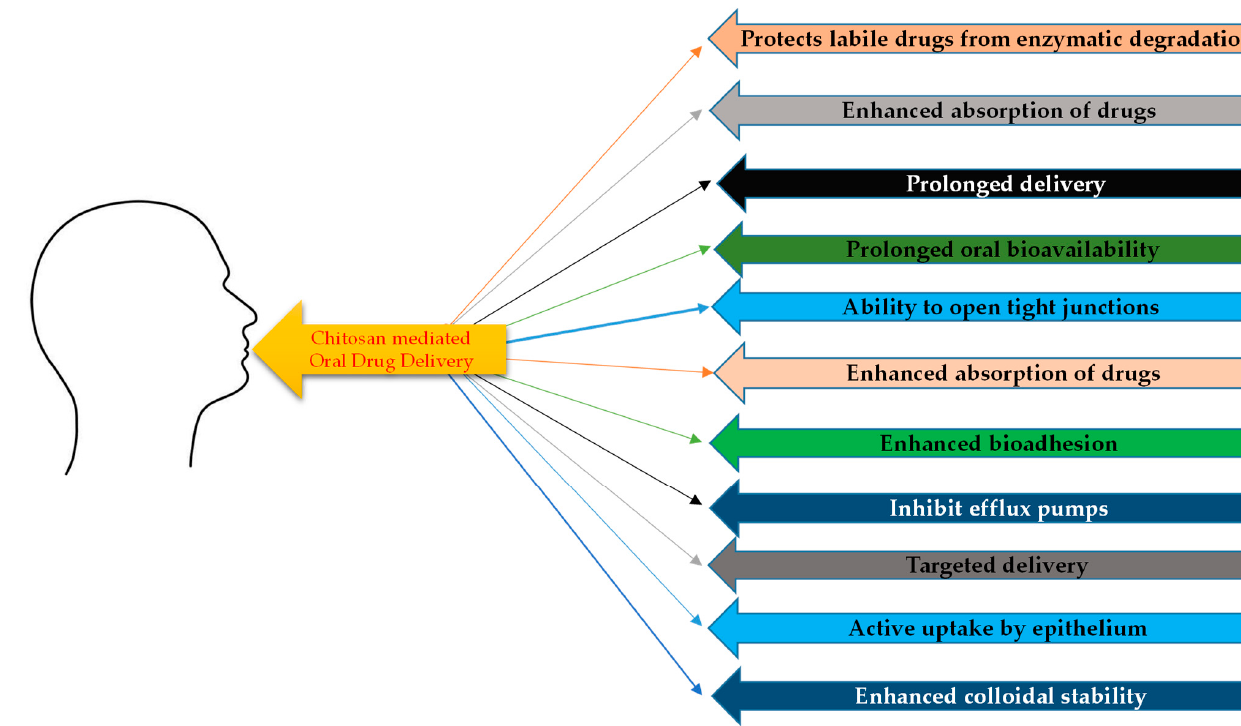
Figure 3. Listings of the limitations in oral drug delivery that chitosan and its derivatives have helped overcome.